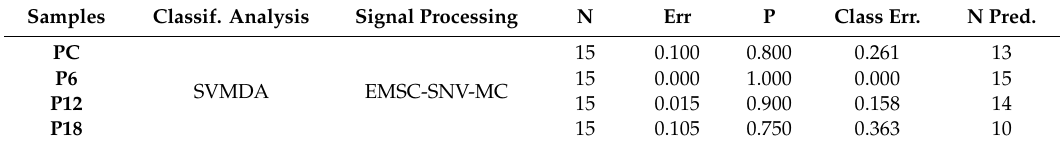
Table 2. Statistics and results of the classification